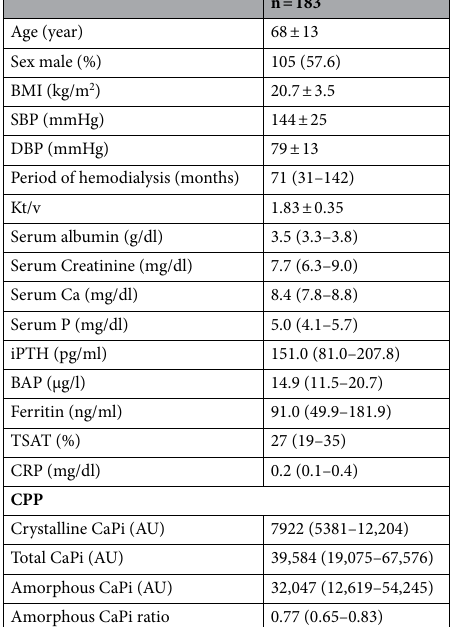
Table 1. Clinical and laboratory characteristics of the participants. Data are expressed as mean ± SD or number or median (interquartile range). BMI body mass index, SBP systolic blood pressure, DBP diastolic blood pressure, iPTH intact parathyroid hormone, BAP bone specific alkaline phosphatase, TSAT transferrin saturation, CRP C-reactive protein.